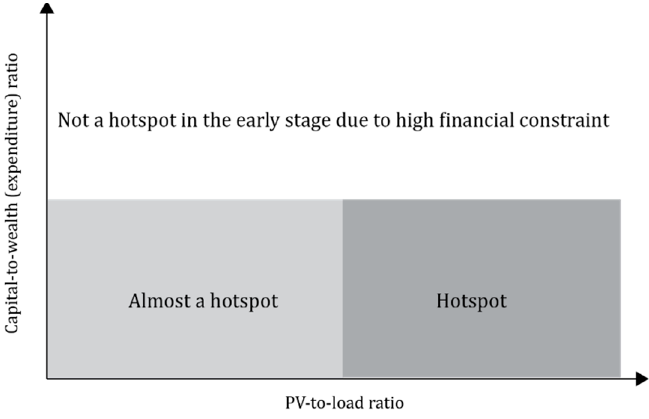
Figure 1. Rooftop PV hotspot determination.